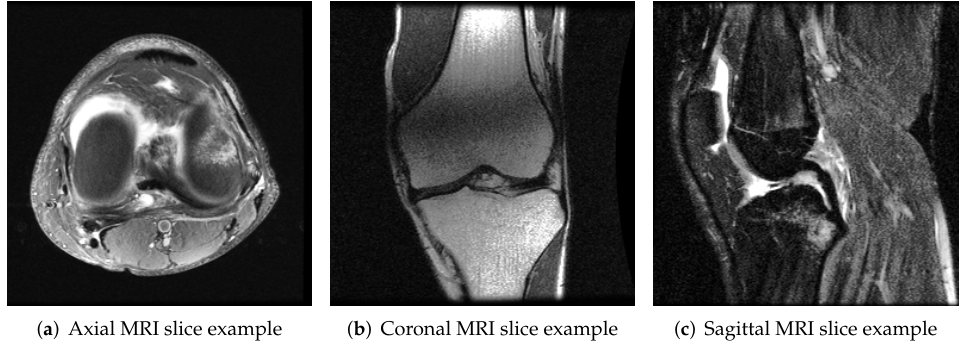
Figure 2. Input image examples of MRNet. Three images represent ( a ) axial, ( b ) coronal and ( c ) sagittal knee MRI